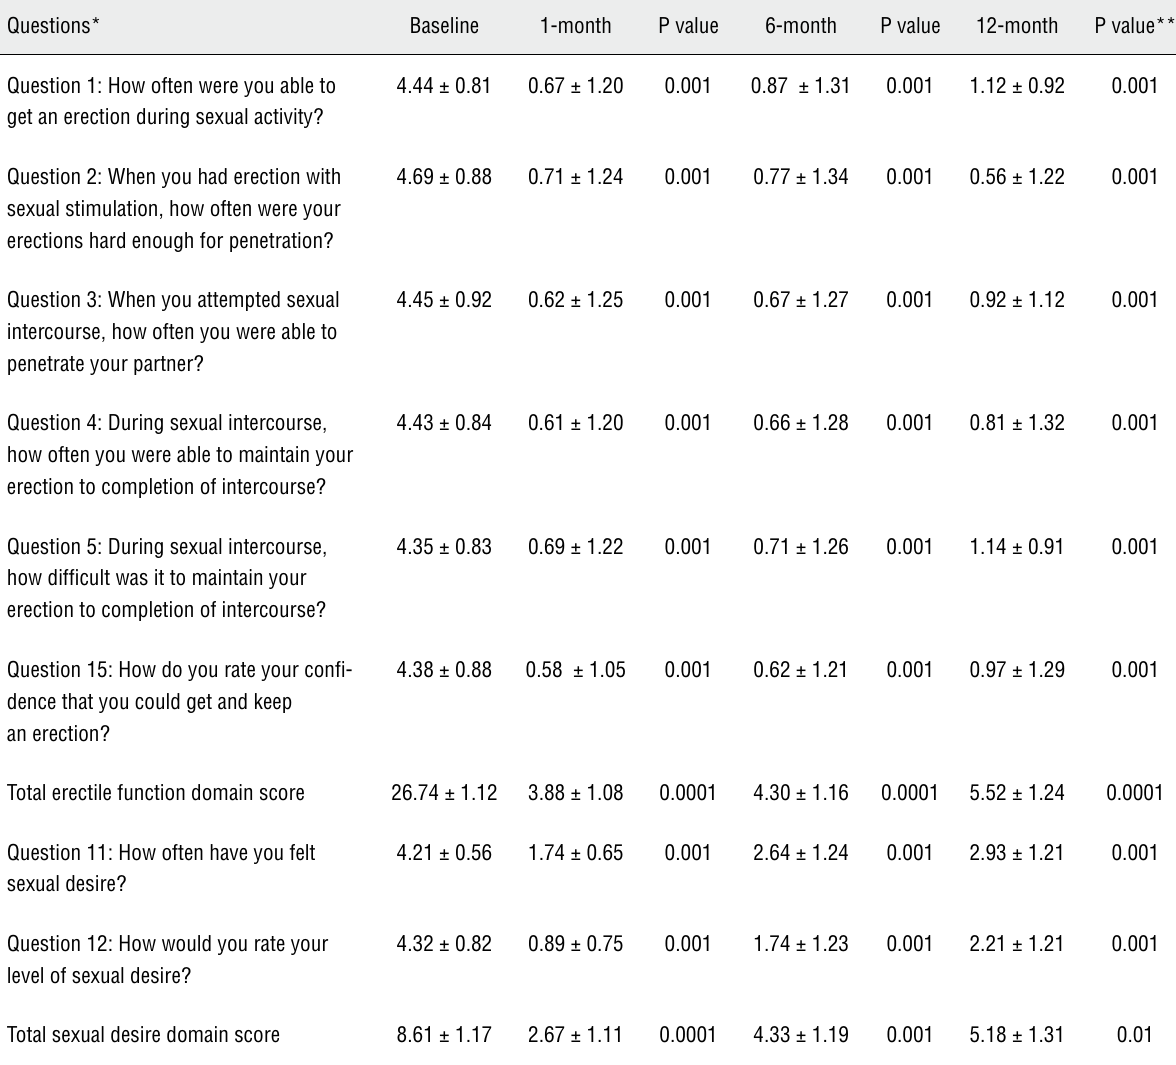
Table 2 - Erectile function and sexual desire domains at baseline and after radical cystoprostatectomy in ileal conduit group.